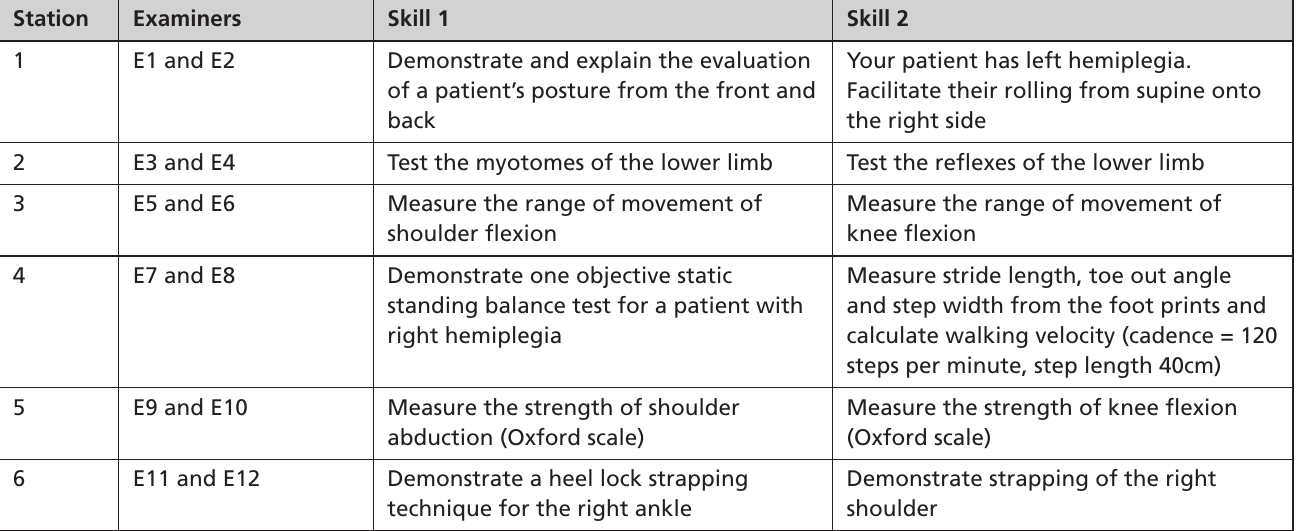
Table 2: The practical skills that the students were assessed on at each station Station